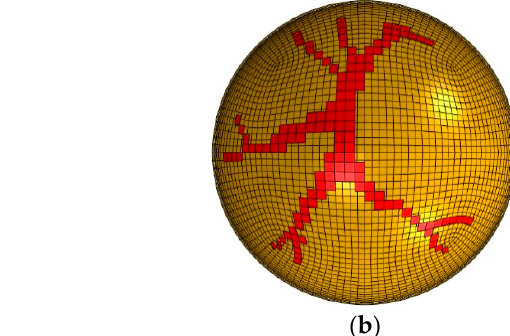
Figure 1. Overall framework to combine FE analysis with an ML method for rapidly predicting soccer-induced posterior retina stress/strain patterns.